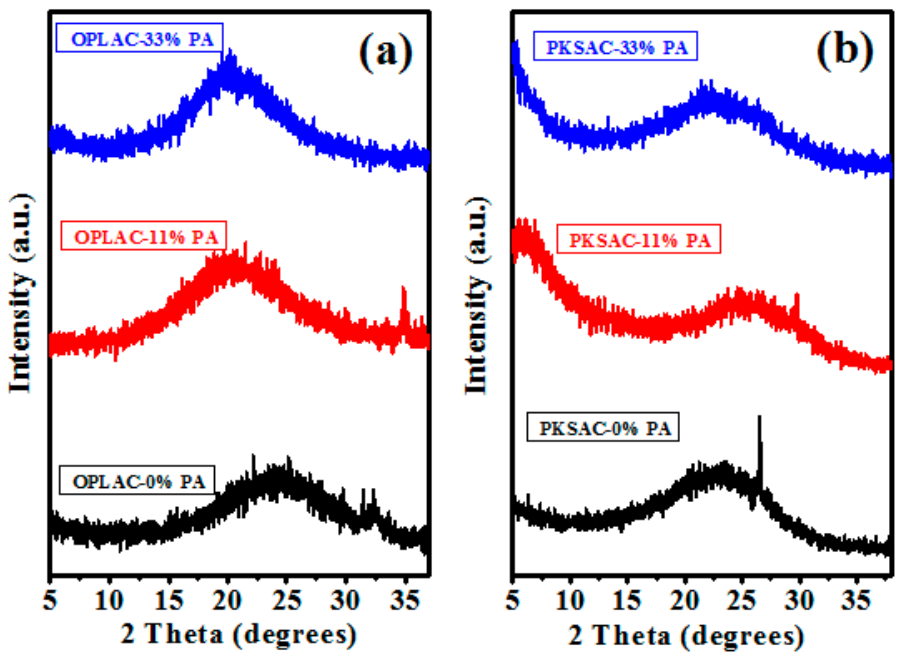
Figure 4. X-ray diffraction pattern of: ( a ) As-prepared activated carbon, synthesized from OPL-derived feedstock at various chemical concentrations (weight %); and ( b ) PKS-derived AC, prepared under the same conditions as in ( a ).